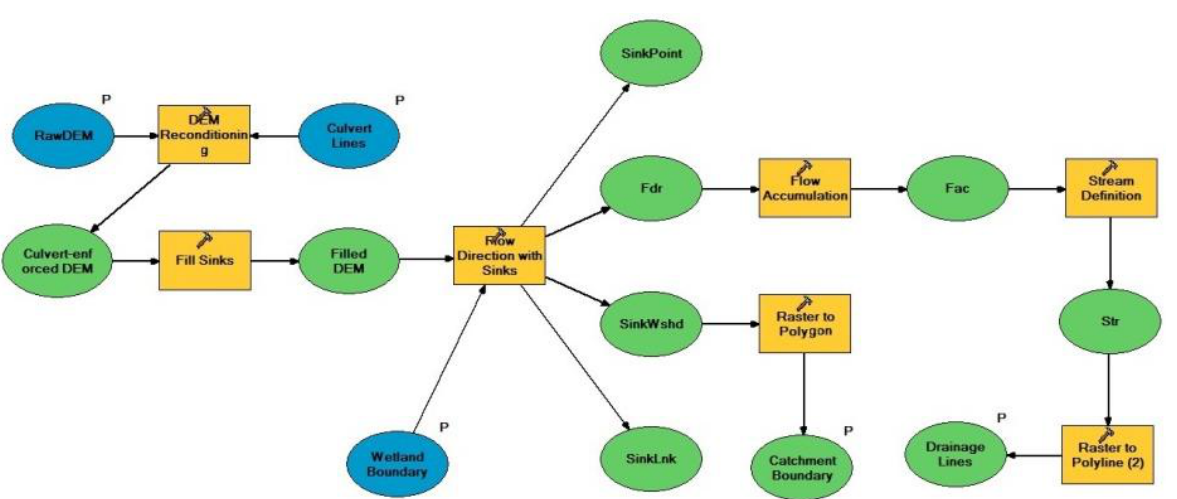
Figure 2. Geoprocessing tools for wetland catchments and drainage delineation in a